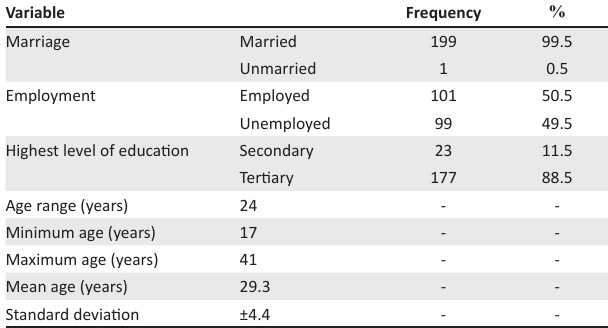
TABLE 1: Sociodemographic variables of the participants.